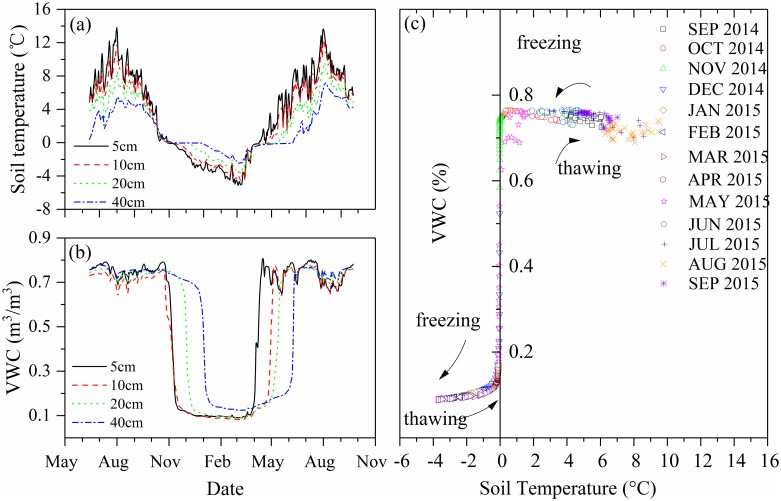
(a) Soil temperature and (b) unfrozen volumetric water content (VWC) at four selected depths (5, 10, 20, and 40 cm), and (c) VWC and soil temperature at 20 cm depth in 2014–2015.